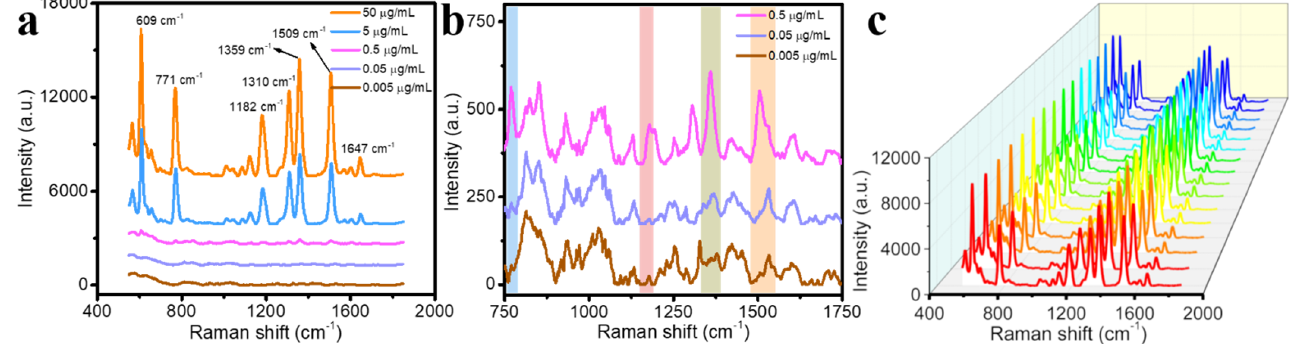
Figure 4. Raman performance of the SERS substrates under the 785 nm wavelength. ( a ) Raman signals of the R6G molecules with concentration value from 5 ng/mL to 50 µg/mL, ( b ) magnified Raman spectra of the R6G molecules from 5 ng/mL to 500 ng/mL and ( c ) sixteen Raman spectra of the R6G molecules with a concentration value of 50 µg/mL.